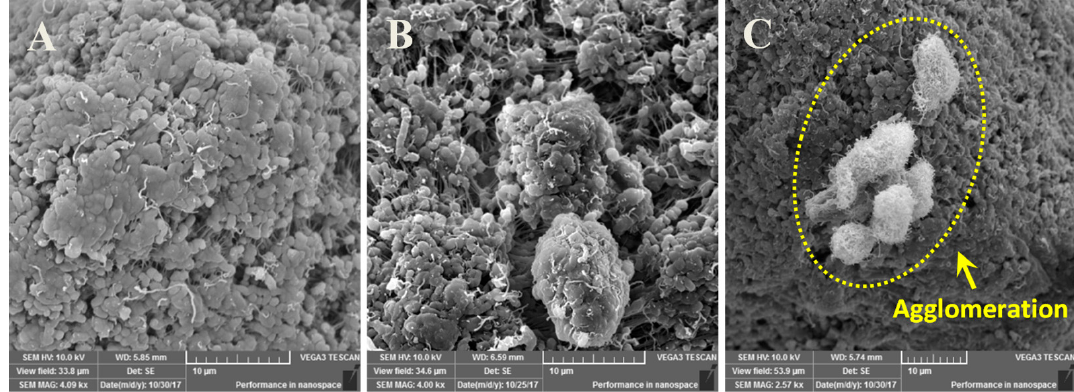
Figure 2. SEM images showing the dispersion of ( A ) 0.5 wt.%, ( B ) 1.5 wt.% and ( C ) 3 wt.% of CNT’s in UHMWPE polymer matrix.